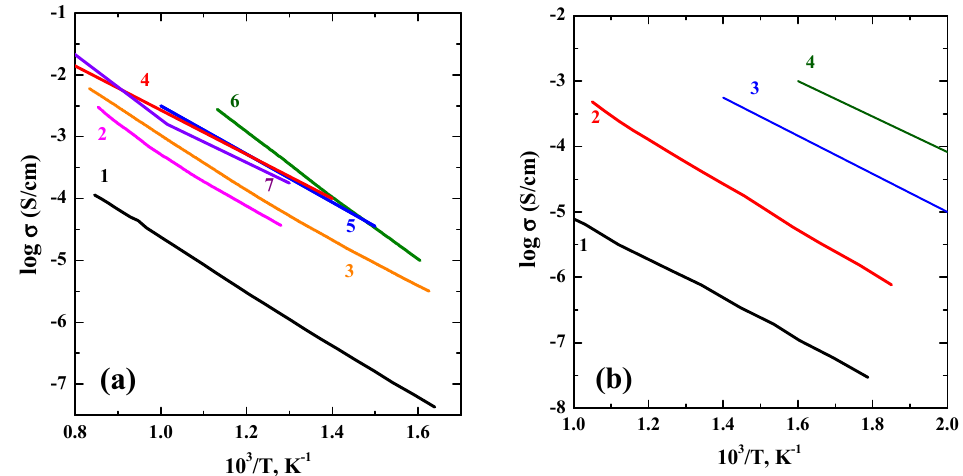
Figure 19. The temperature dependencies of conductivity under dry air ( a ): BaLaInO 4 (1) [76], Sr 0.6 Ba 0.2 La 1.2 InO 4+ δ (2) [74], Ba 1.1 La 0.9 InO 3.95 (3) [76], BaNd 0.9 Sr 0.1 InO 3.95 (4) [68], BaNdIn 0.9 Mg 0.1 O 4 (5) [71], ZrO 2 (8 mol% Y 2 O 3 ) [74] (6), BaGd 0.9 Ca 0.1 InO 3.95 [115] (7) and under wet air ( b ): BaLaInO 4 (1) [76], Ba 1.1 La 0.9 InO 3.95 (2) [76], SrCeO 3 (10 mol% Y 2 O 3 ) (3) [119], BaCeO 3 (10 mol% Y 2 O 3 ) (4) [119].